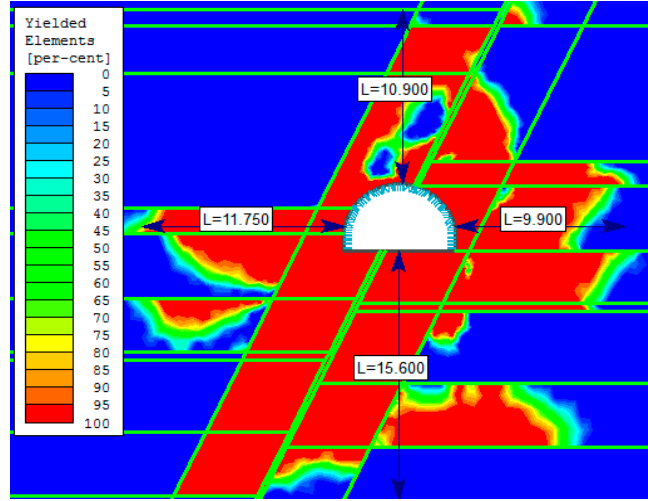
Figure 20. Model no. 3—Fault zone, yielding support—map of yielded rock mass elements around the roadway